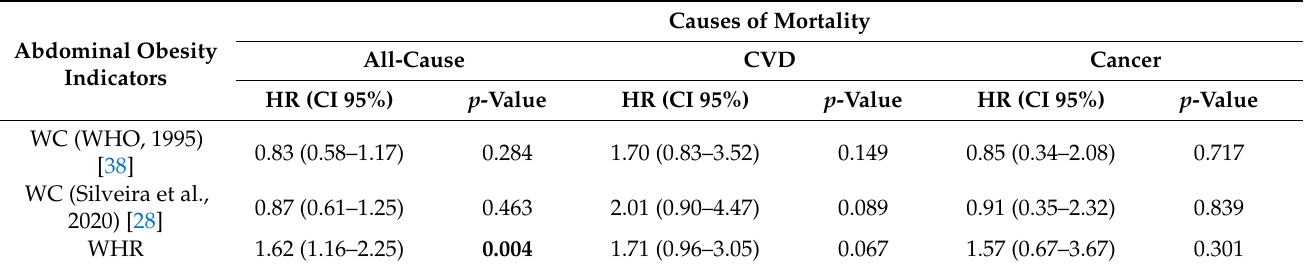
Table 2. Unadjusted association between abdominal obesity indicators and causes of mortality-Cox